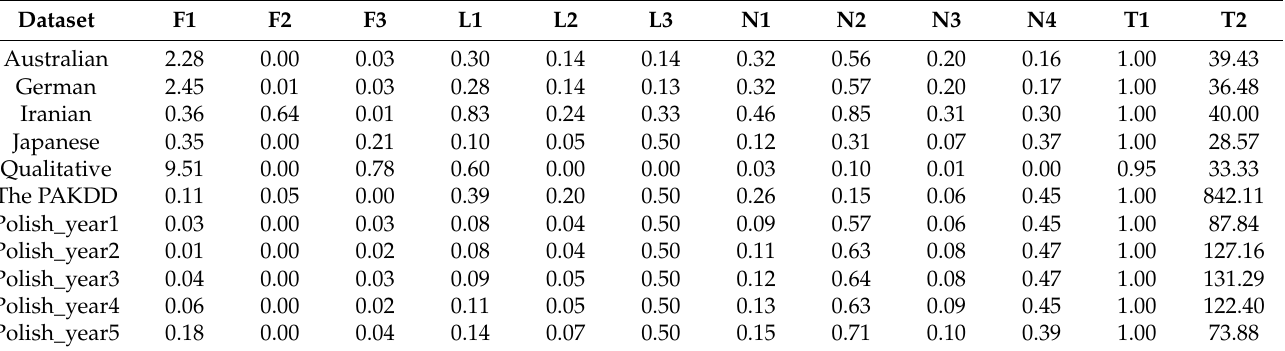
Table 4. Complexity measure values for the datasets used.